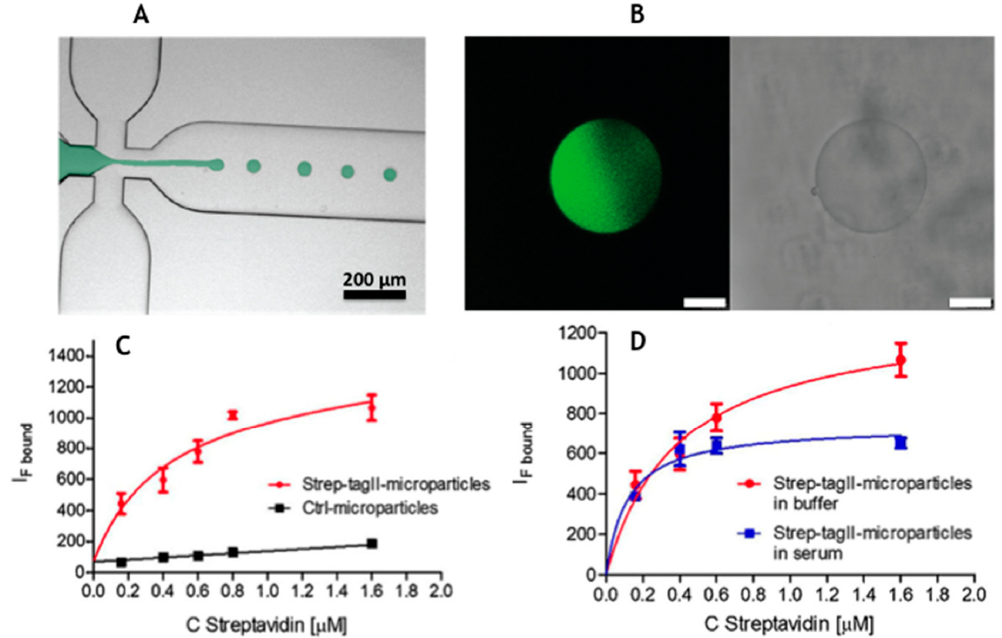
Figure 4. ( A ) Hydrogel microparticles with Strep-Tag II copolymerized with PEGDA are realized by flow-focusing droplet generation approach; ( B ) the generated droplet photopolymerized inside the microfluidic channel provide monodisperse particle (diameter 88 μ m, sd 5 μ m) with uniformly distributed peptide sequence co-polymerized inside the gel (size bar is 20 μ m); and ( C and D ) in the lower part of the figure are reported the isotherm binding curve of the Atto-425 Streptavidin captured on by Strep Tag II microparticles over a control in PBS and in serum (adapted with permission from [39], copyright 2016 Elsevier B.V.).